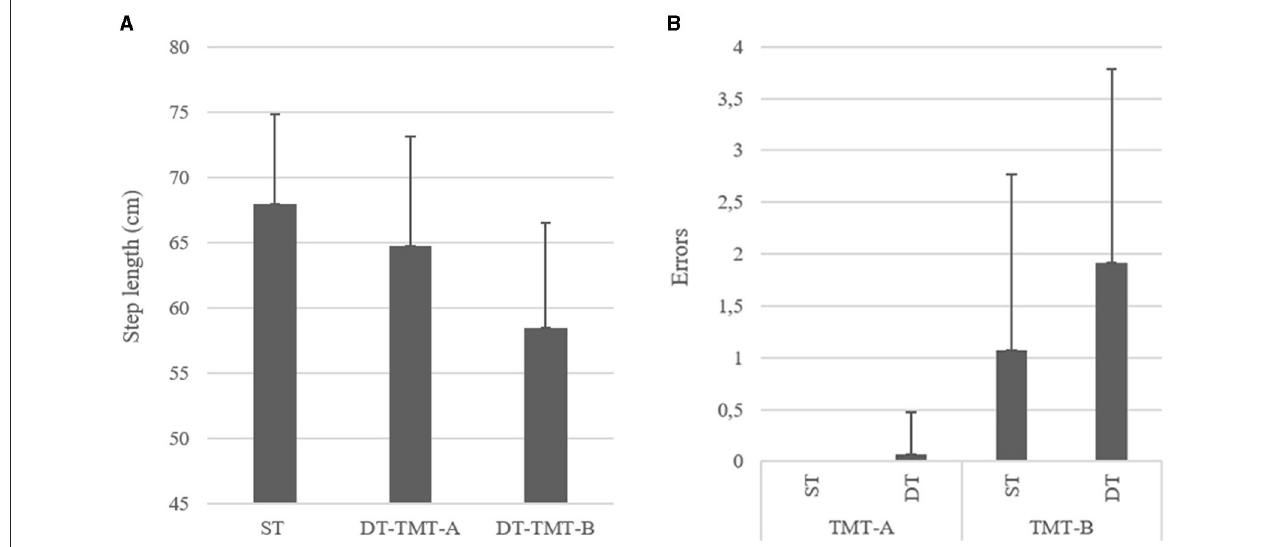
FIGURE 2 | (A) Left and (B) right, respectively, showing the differences between conditions on errors on the cognitive tests and step length (cm) in the whole sample (TMT-A, Trail Making Test part A; TMT-B, Trail Making Test part B; ST, Single Task; DT, Dual-Task).